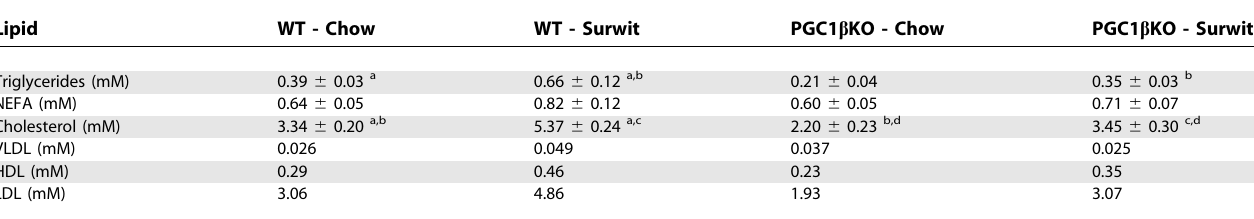
Table 3. Serum Lipid Biochemistry from 24-h Surwit Diet–Fed WT and PGC1 b KO Mice Lipid WT - Chow WT - Surwit PGC1 b KO - Chow Triglycerides